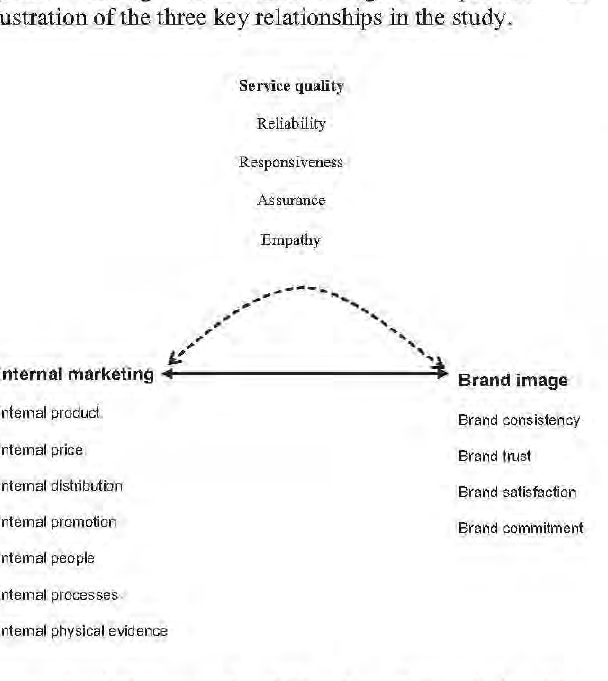
Figure 1: A framework of the three key relationships explored in the